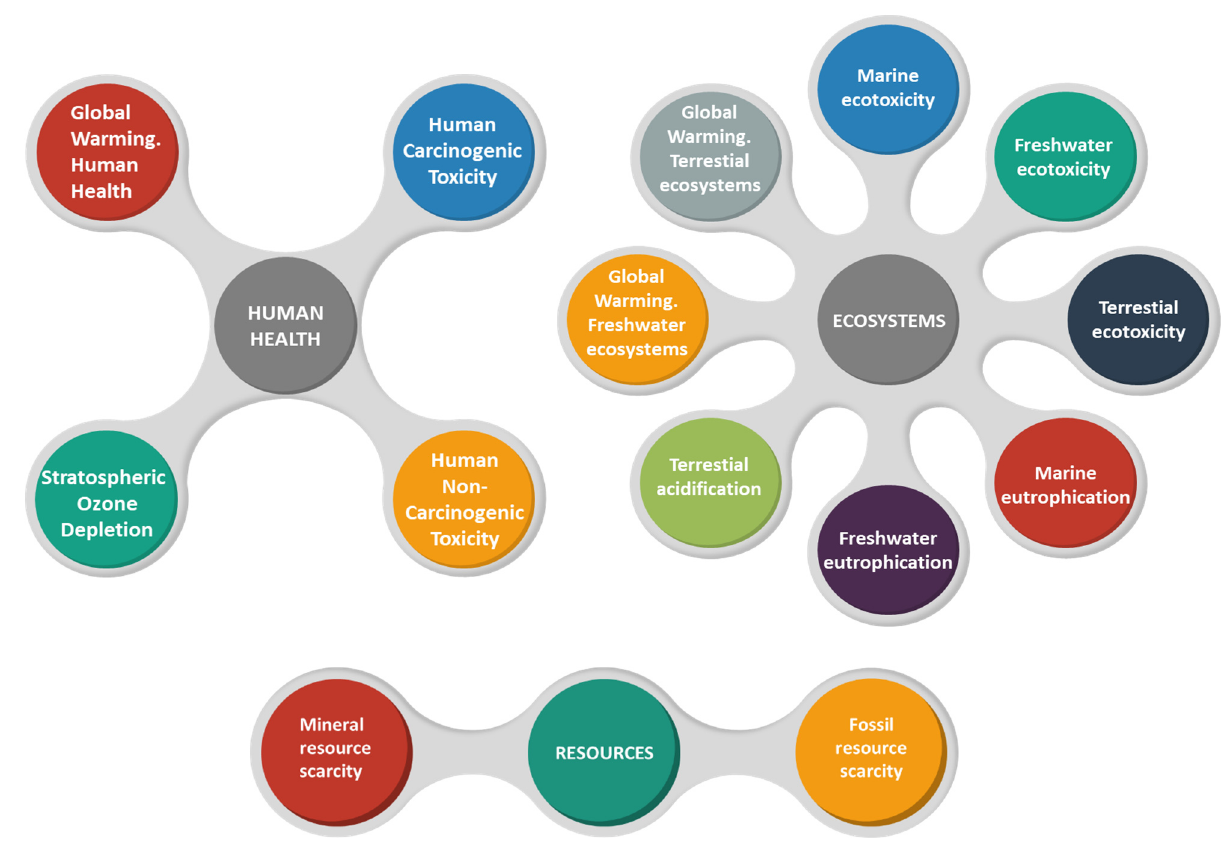
Figure 7. Endpoint characterization factors with midpoint categories and single score value calculation